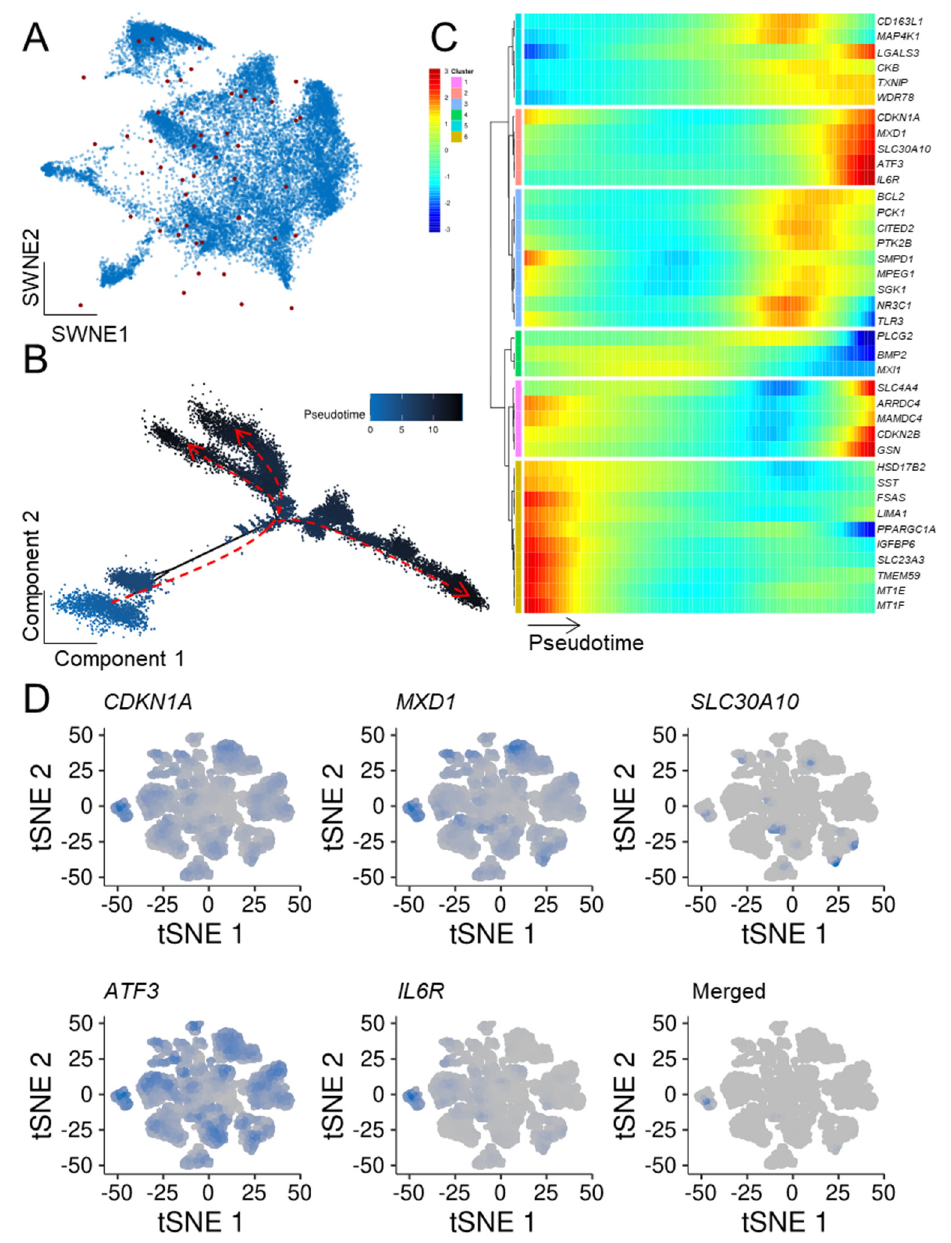
Figure 4. Colorectal cancer cells show a distinct population high in ASIG expression. ( A ) Epithelial cells isolated from CRC samples of 23 patients (GSE132465 [51]) were depicted in an SWNE weighted according to 49 previously defined and robustly expressed ASIGs (depicted as red dots). ( B ) Pseudotime analysis revealing early (bottom, blue) and late (top, black) fates. ( C ) Expression patterns along pseudotime indicated two clusters (orange and pink) displaying late upregulation of ASIGs. ( D ) Independent tSNE clustering of ASIGs enriched in late development phases of epithelial CRC cells.